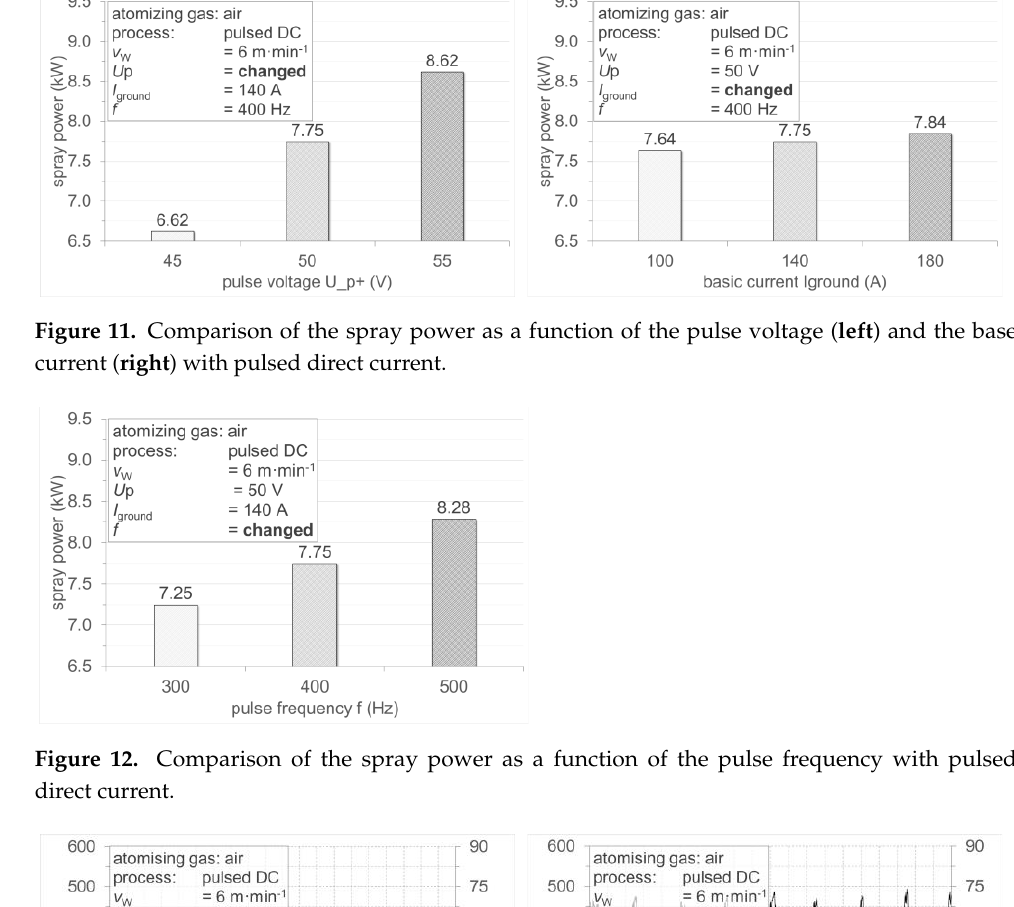
p = 45 V, ( right ): U P = 55